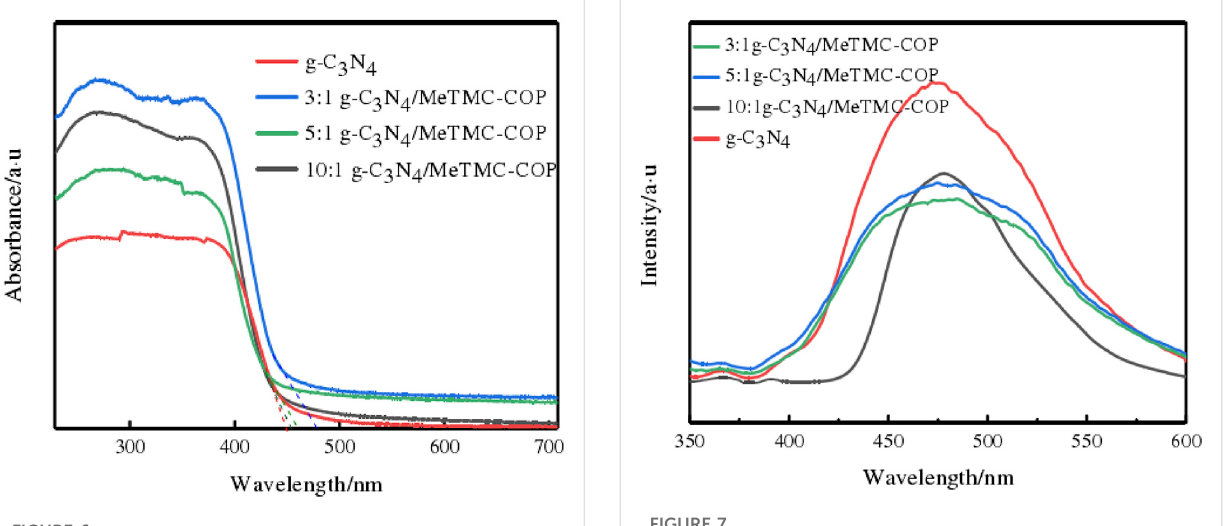
Figure 5A, and the catalyst ’ s pore size distribution map is shown in Figure 5B. The nitrogen adsorption-desorption isotherms of g-C 3 N 4 , 3:1 g-C 3 N 4 /MeTMC-COP, and MeTMC-COP may be inferred from the relative pressure (P/P 0 ) hysteresis loop ’ s curve shape in Figure 5A. Designated as type IV. The speci fi c surface area of